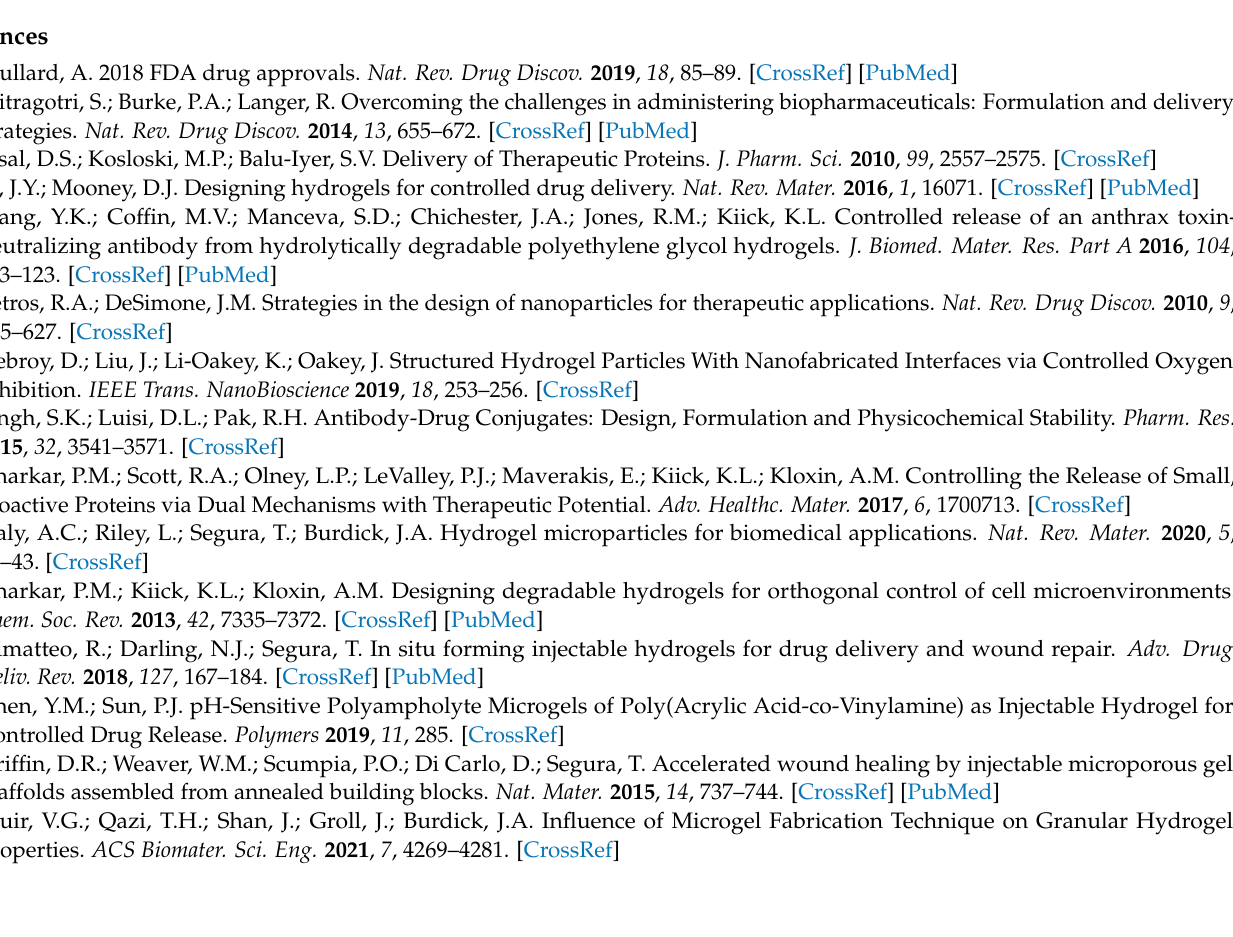
sweep plots; Figure S16: Microgels formed by inverse suspension polymerization; Figure S17: Micro- gels injected through a